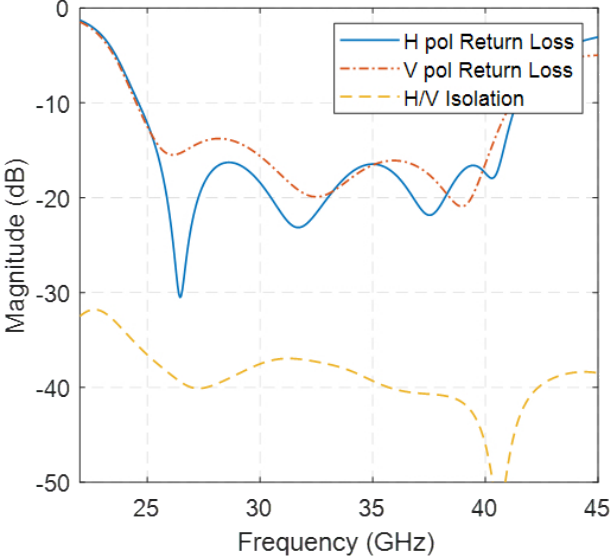
Figure 5. H and V polarization return loss and H/V isolation at the end of the optimization.